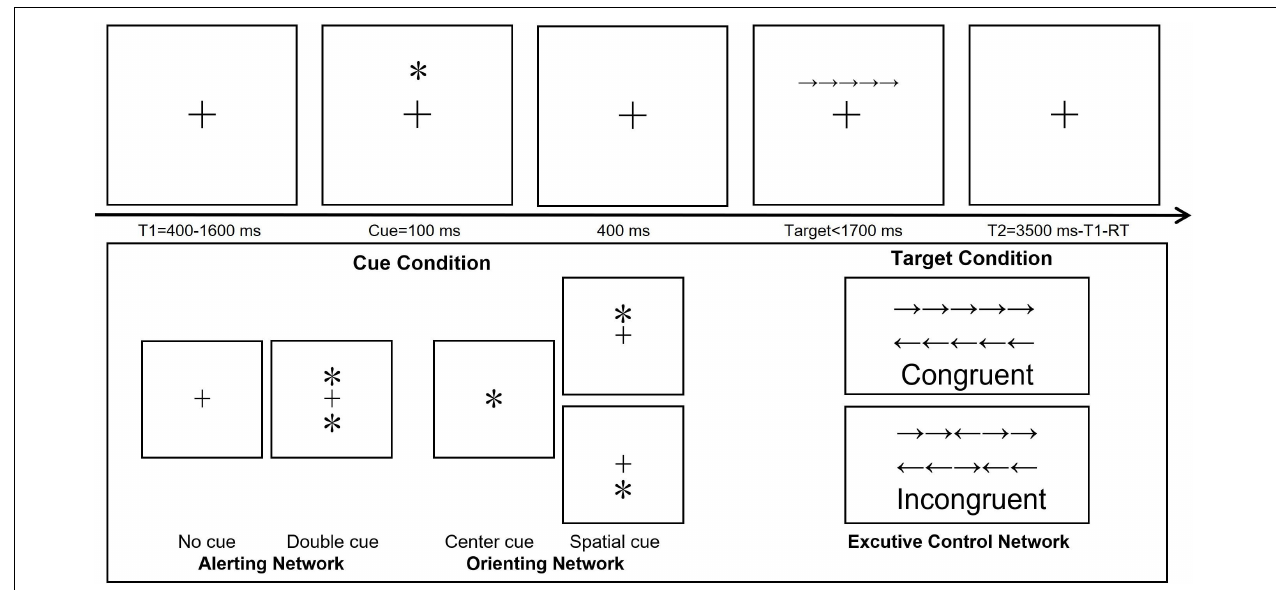
FIGURE 1 | Schematic diagram depicting the Attention Network Test paradigm. T1, represents the fixation time; T2, the interval between two trials; RT, response time. ∗ Means the cue types in the altering and orienting networks of ANT.